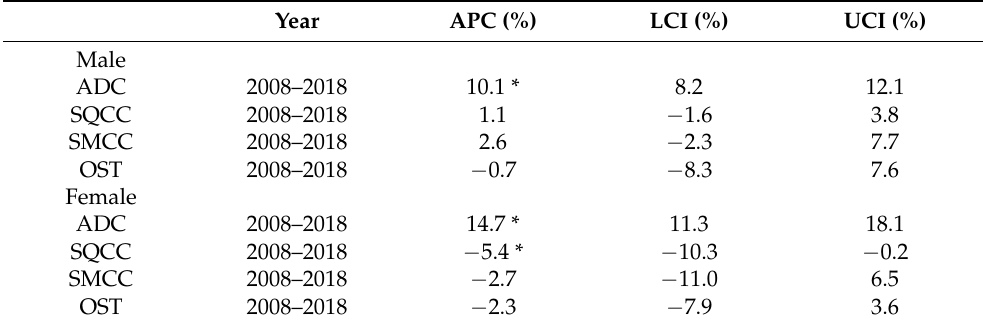
Table 3. Thetrendofage-standardizedincidenceoflungcancerbyhistologicaltypeinShenzhen,2008–2018.